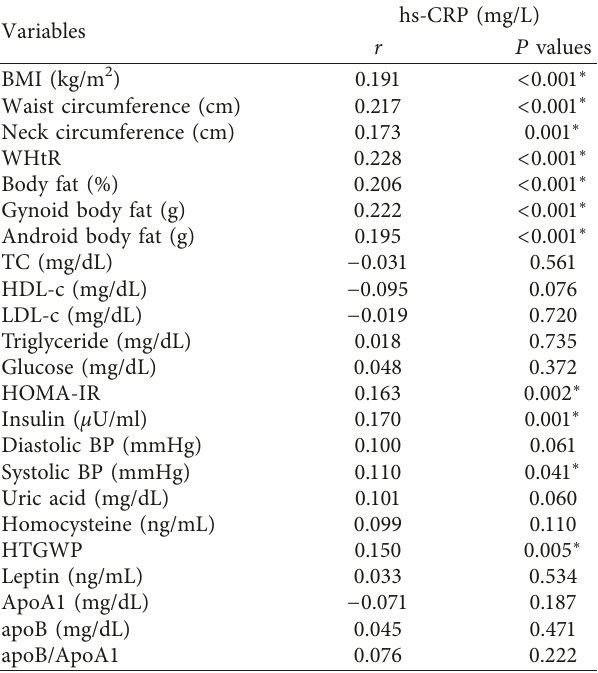
Table 3: Spearman’s correlation between serum hs-CRP concen- tration and anthropometric, biochemical, and clinical parameters in children, Viçosa, MG, Brazil,